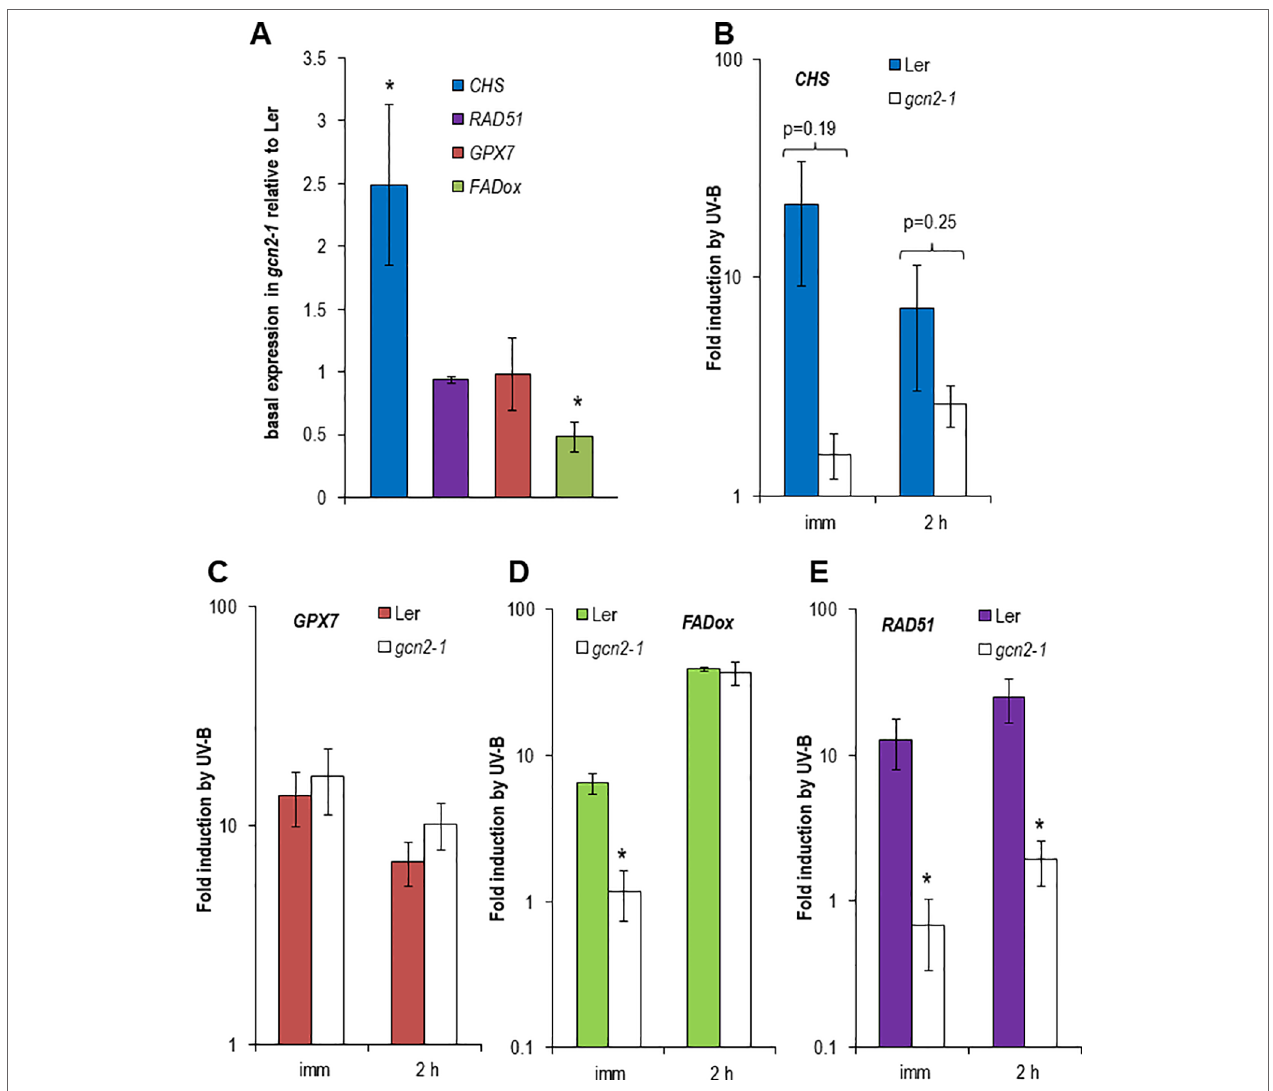
FIGURe 3 | Expression of reporter genes dependent or independent of UVR8 and indicative for DNA damage in wildtype Ler and gcn2-1 . In total, the expression of four different experiments (i.e. biological repeats) was quantified. Each cDNA was measured in triplicate. Data represent the mean and standard errors of the normalized expression to three reference genes. (A) Basal expression relative to the wildtype Ler using normalized data of three reference genes. (B – e) Fold induction by UV-B immediate and 2 h after a 1.5 h exposure to broad band UV-B of (B) the UVR8 dependent CHS , (C) the UVR8 dependent GPX7 , (D) the UVR8 independent FADox and (e) the DNA damage induced RAD51 . Stars indicated significant different expression to wildtype.